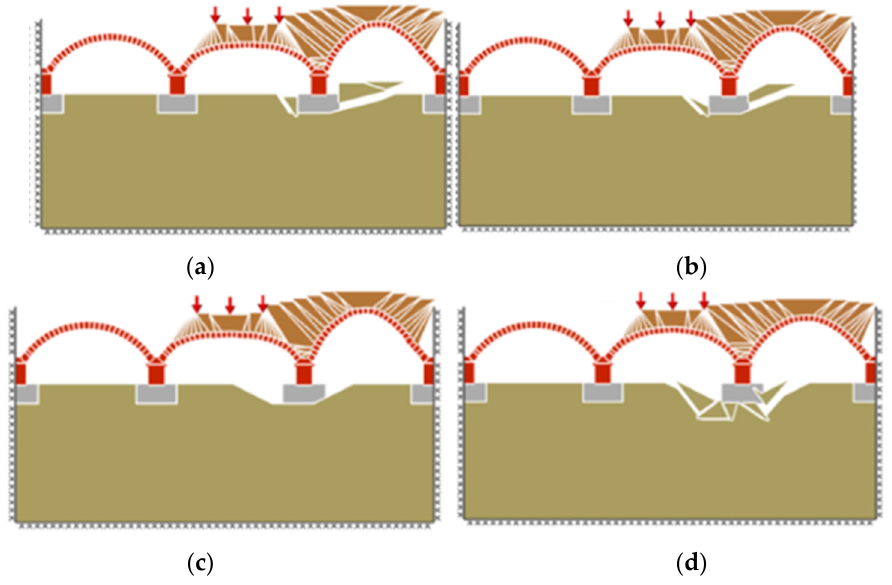
Figure 8. Collapse mechanisms at different stages of the scouring process with respect to the footing thickness ( F t ): ( a ) Stage 0: no scour; ( b ) Stage 1: scour depth smaller than F t ; ( c ) Stage 2: scour depth equal to F t ; ( d ) scour depth larger than F t .